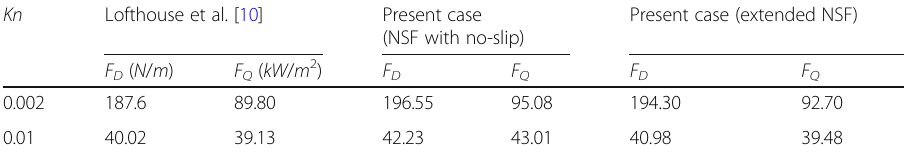
Table 3 Comparison of the total drag and peak heat transfer rates for the extended Navier-Stokes- Fourier (NSF) with the slip and jump conditions Kn Lofthouse et al. [10] Present case Present case (extended NSF) (NSF with no-slip)